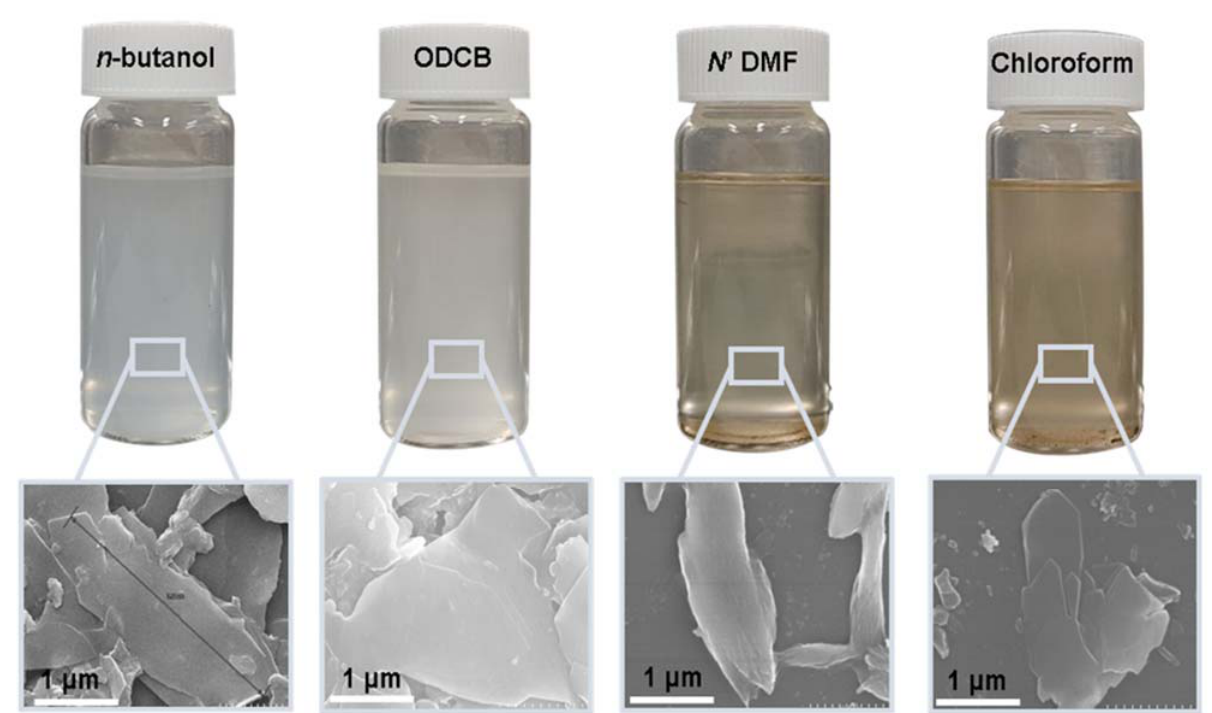
Figure 5. Suspension of exfoliated nanosheets in organic solvents in order of most stable suspension to agglomerated and stacked nanosheets ( n ‐ butanol > o ‐ DCB > N’N’ DMF > chloroform).